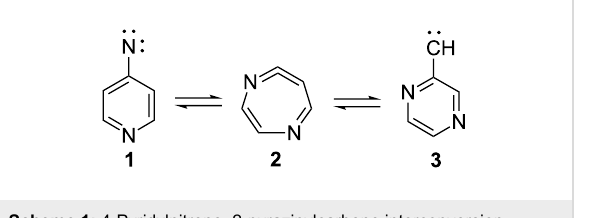
Scheme 1: 4-Pyridylnitrene–2-pyrazinylcarbene interconversion.